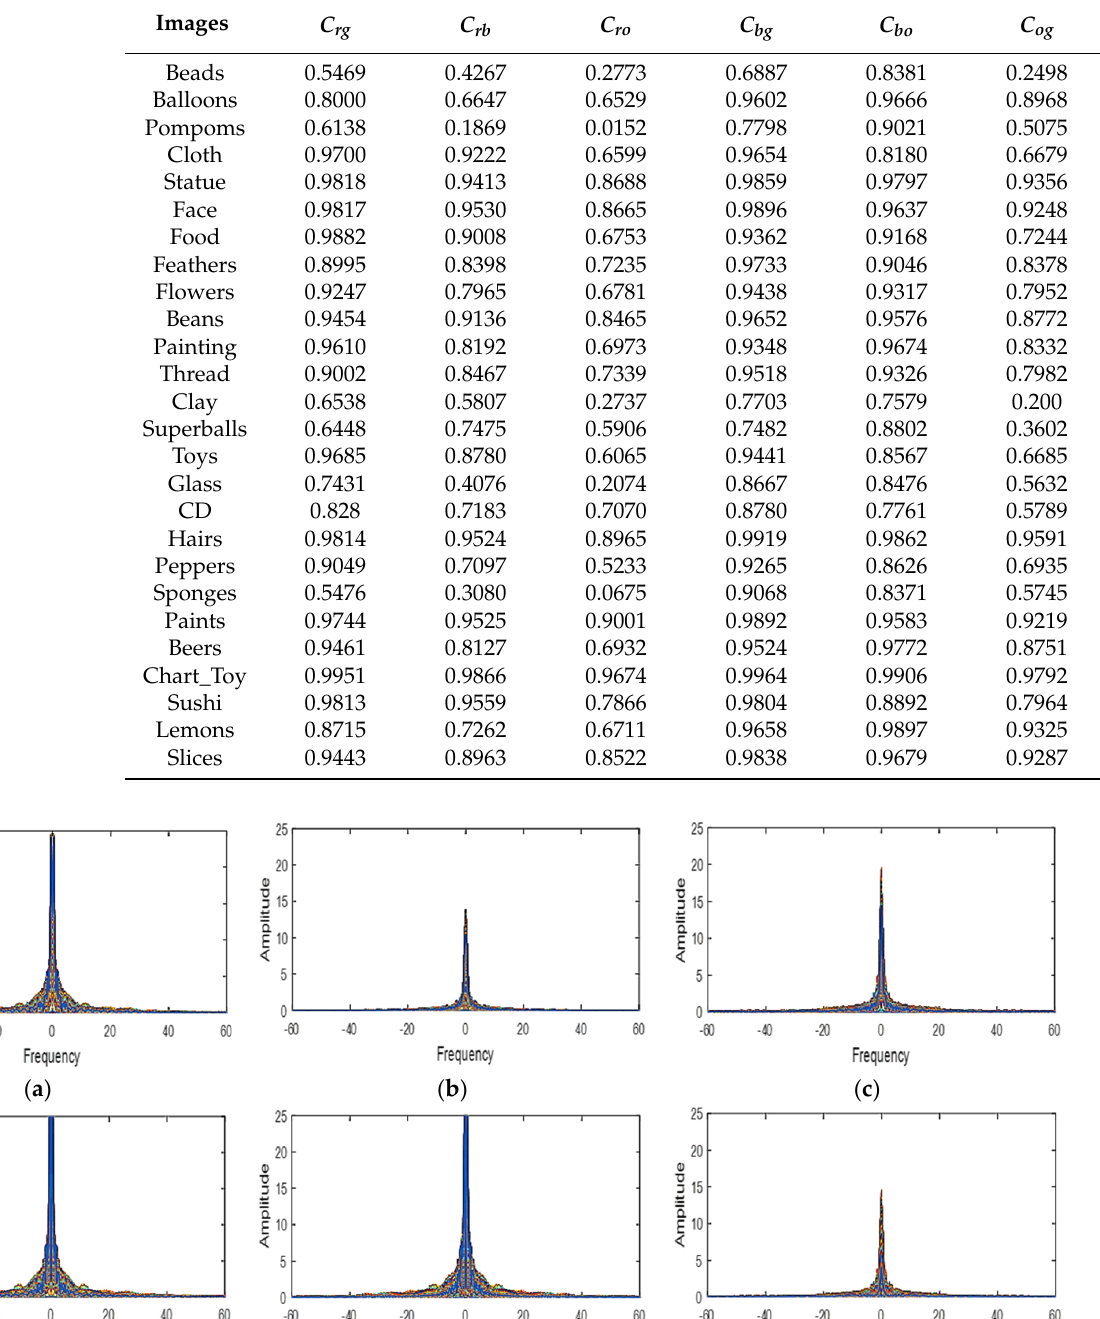
Table 1. Spectral correlation coefficients for red/green ( 𝐶 (cid:3045)(cid:3034) ), red/blue ( 𝐶 (cid:3045)(cid:3029) ) , red/orange ( 𝐶 (cid:3045)(cid:3042) ),